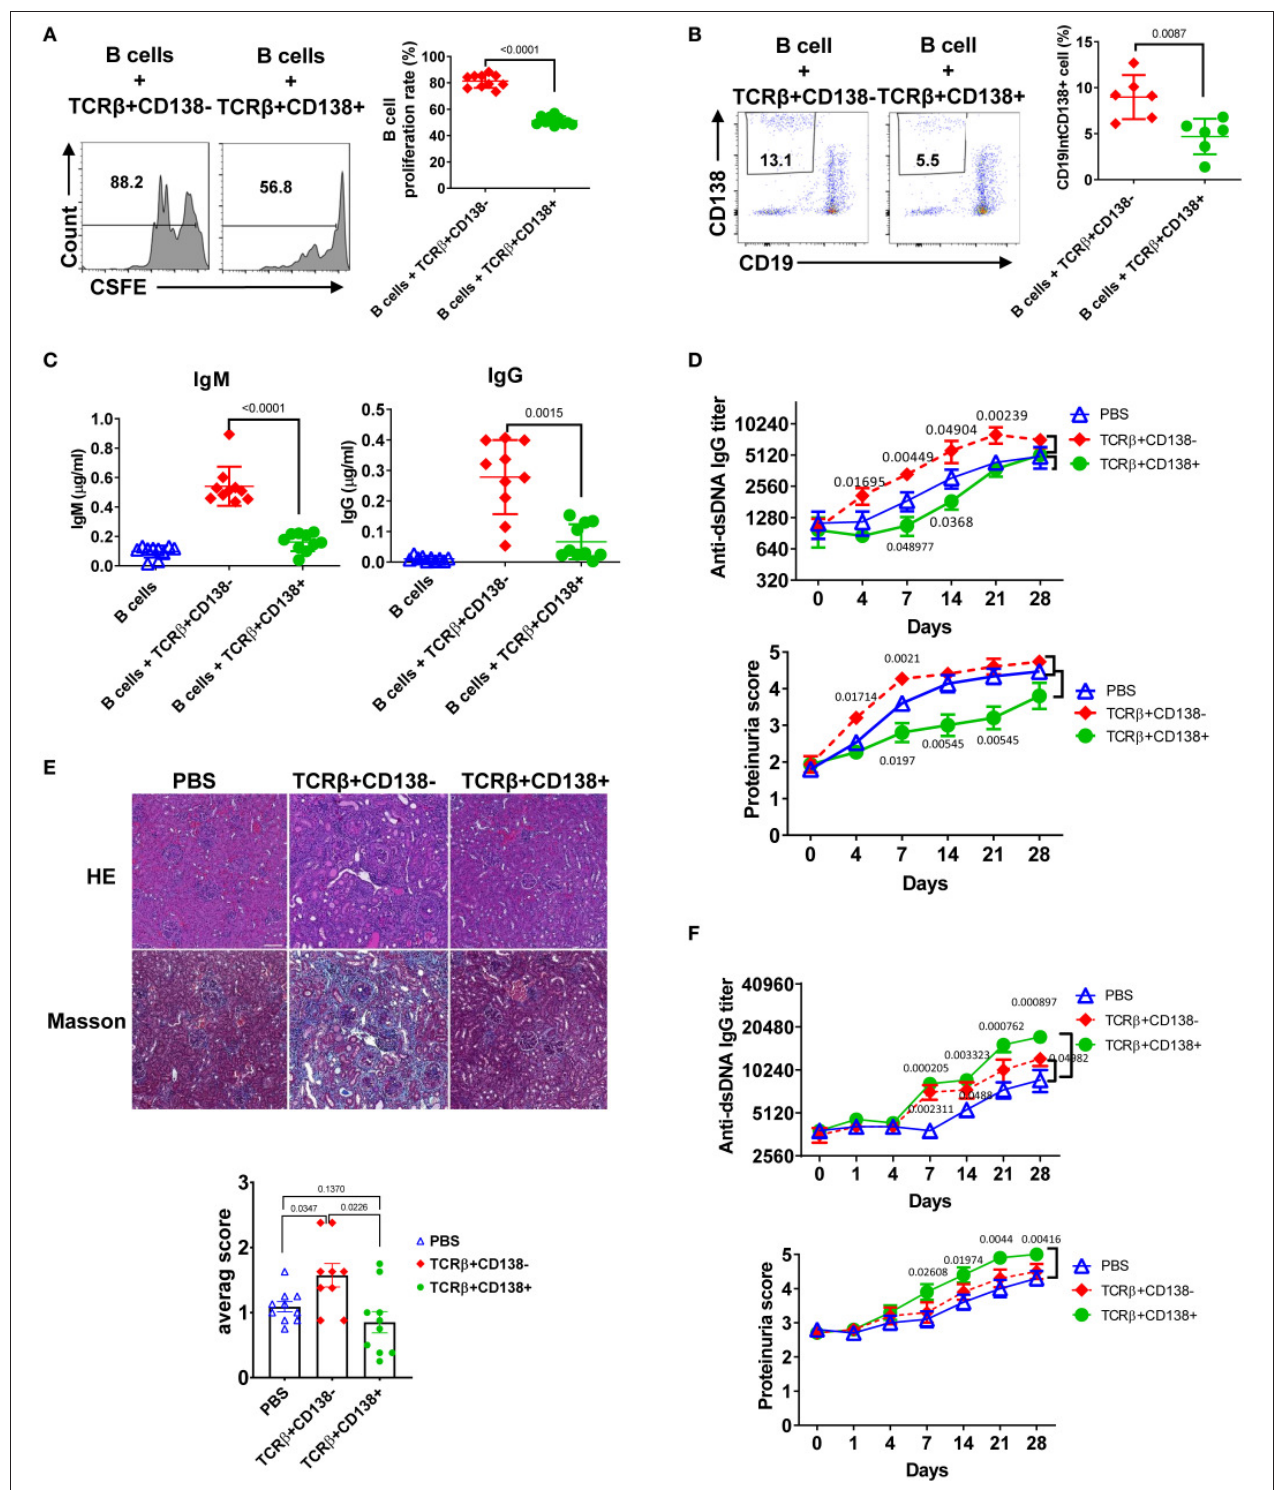
FIGURE 4 | TCR β + CD138 + cells are unable to promote lupus diseases development in young MRL/Lpr mice. (A–C) Sorted splenic TCR β + CD138 + and TCR β + CD138- cells from 10 to 12 weeks old MRL/Lpr mice were co-cultured with purified splenic B cells from 6 weeks old mice in the presence of